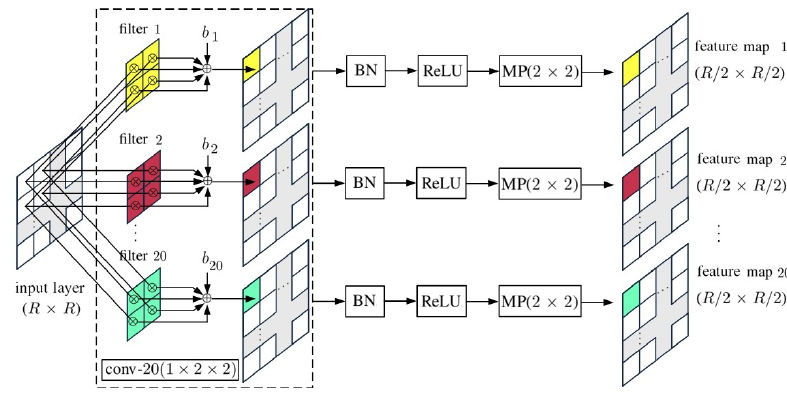
Figure 11. Schematic of convp-20 ( 1 × 2 × 2 ) .